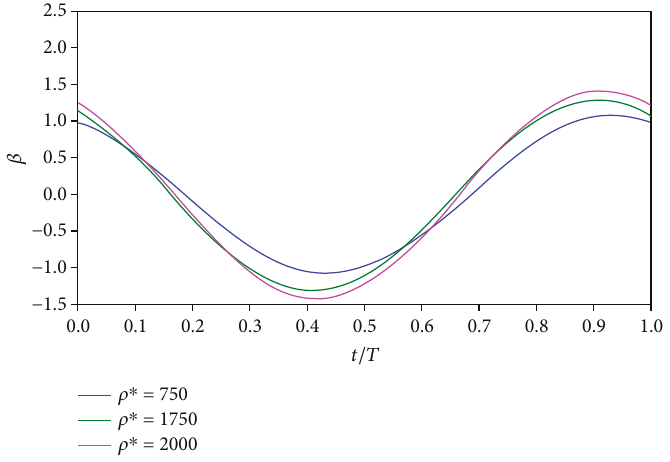
Figure 14: Time variation of passive pitching angle of fl exible wings with ρ ∗ = 750 , 1750, and